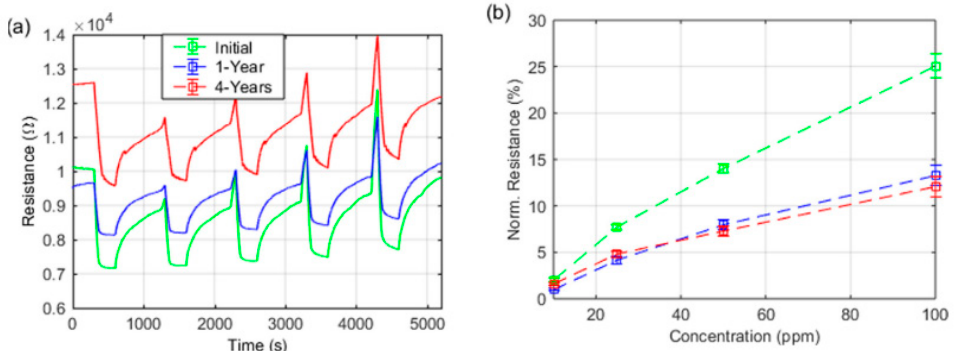
Figure 4. ( a ) Response to NH 3 vs. time after 1 day, 1 year, and 4 years from fabrication; ( b ) Calibration curves for NH 3 after 1 day, 1 year, and 4 years from fabrication [152]. IOP Publishing. Reproduced with permission. All rights reserved.